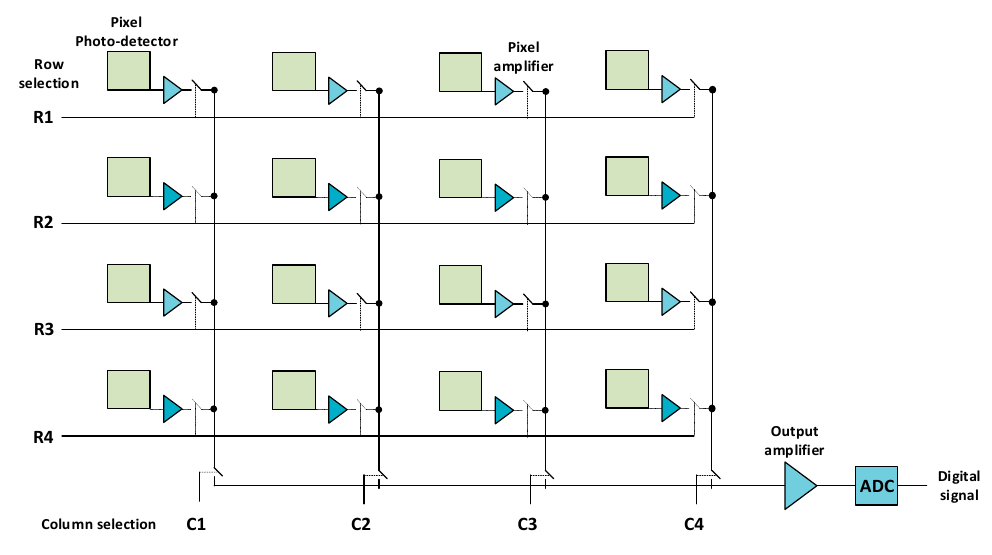
Figure 4. Schematics of a CCD image sensor.